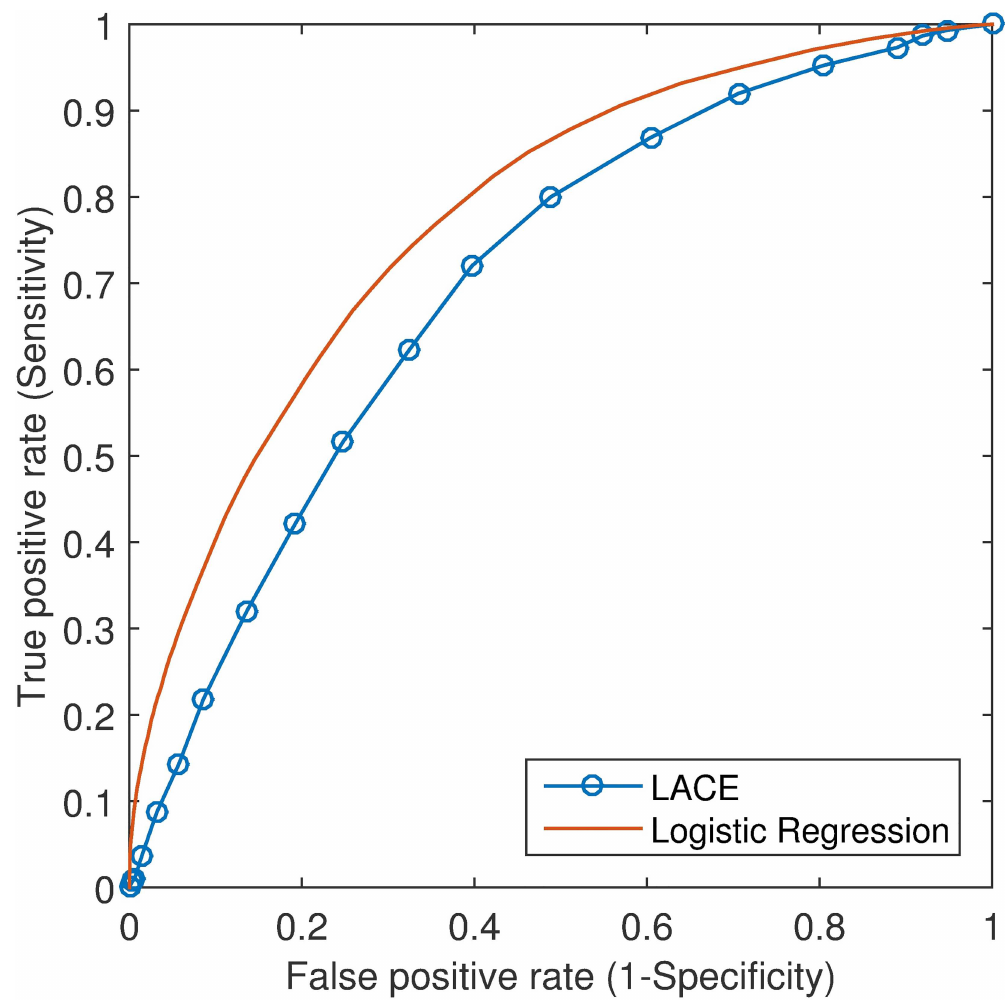
Fig 2. ROC curves of the LACE index and our logistic regression